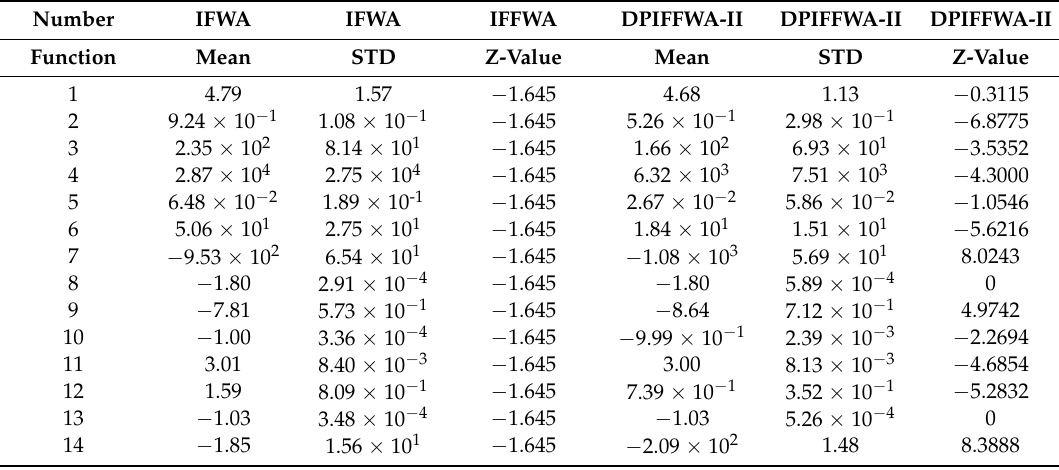
Table 12. Hypothesis test between IFWA and DPIFFWA-II with SI =